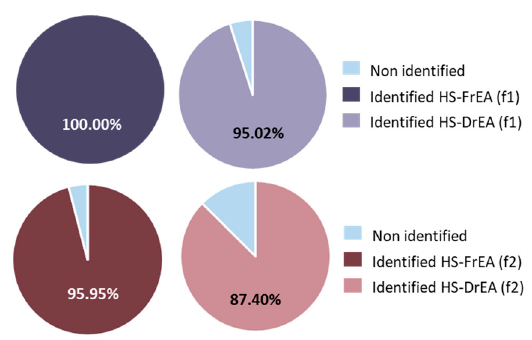
Figure 5. Diagram showing the portion of identified compounds in the headspace of E. amentacea . HS-FrEA—headspace of fresh E. amentacea ; HS-DrEA—headspace of air-dried E. amentacea ; f1—ex-